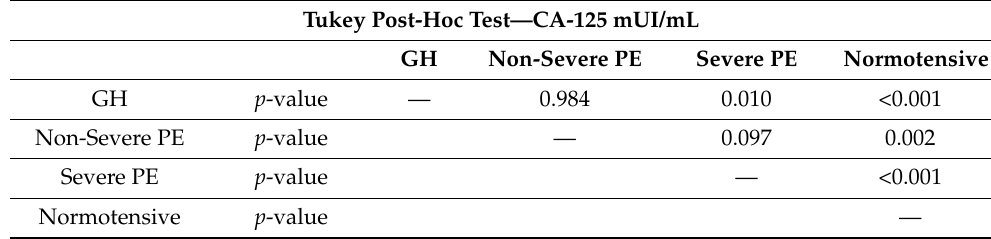
Figure 1. Mean values of CA-125 in the study population. Table 3. Statistical significance of CA-125 levels between study